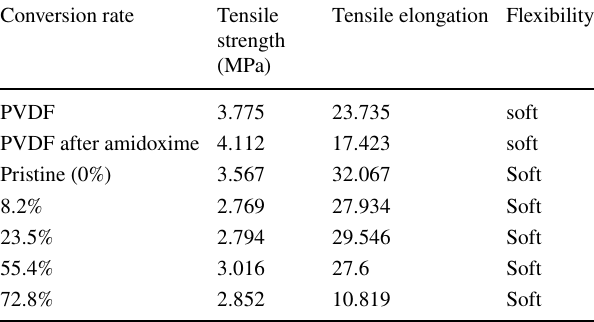
Table 3 Mechanical strength and softness of the neat PVDF